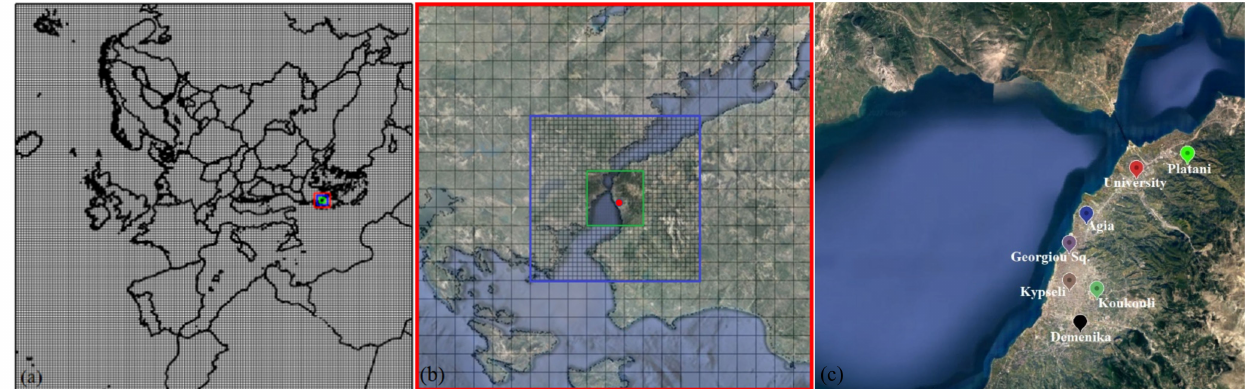
Figure 2. ( a ) The European domain with 36 × 36 km 2 resolution (d01), ( b ) the nested domains with increasing spatial resolution, 12 × 12 (red) (d02), 3 × 3 (blue) (d03) and 1 × 1 (green) (d04) km 2 and ( c ) locations of the discussed sites in the city of